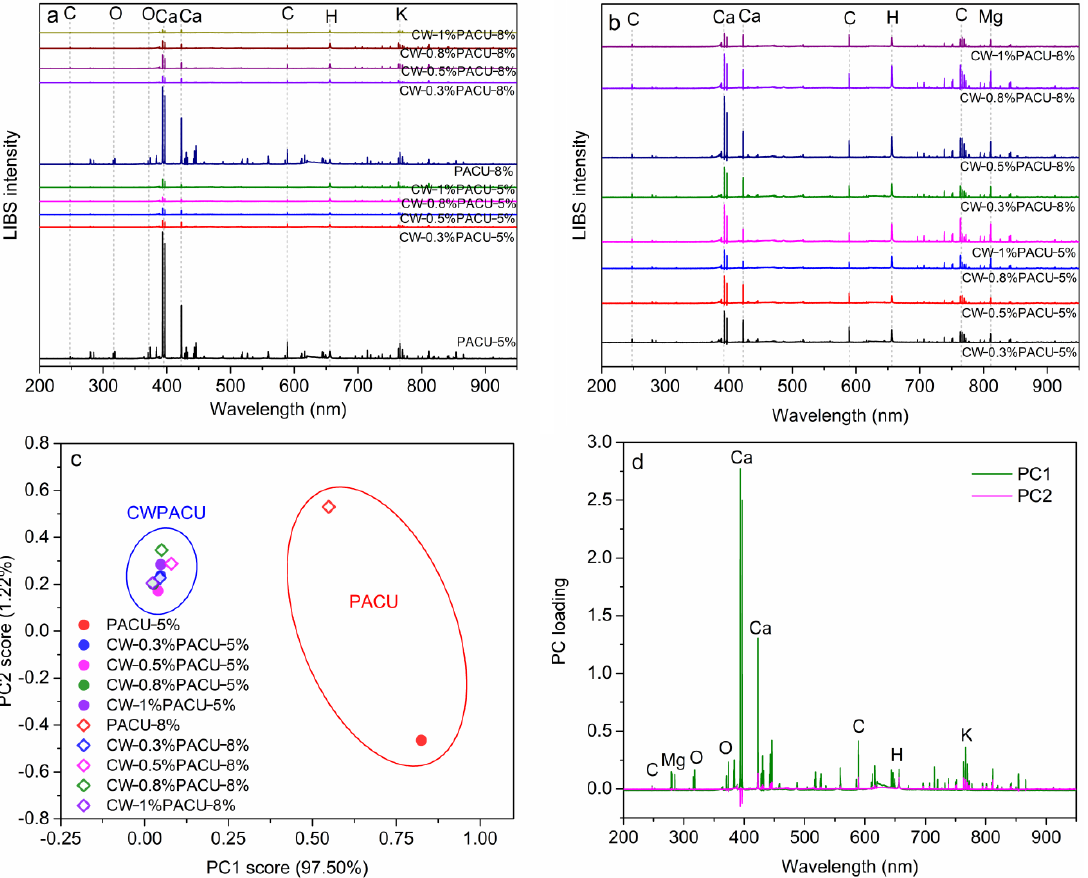
Figure 5. LIBS spectral characteristic of the PACU and CWPACU. ( a ) Comparison between the LIBS spectra of PACU and CWPACU. ( b ) Comparison between the LIBS spectra of CWPACU with different CW loading amounts. ( c ) Principal component scores of LIBS spectra for PACU and CWPACU. ( d ) Principal component loading of LIBS spectra for different PACU and CWPACU.